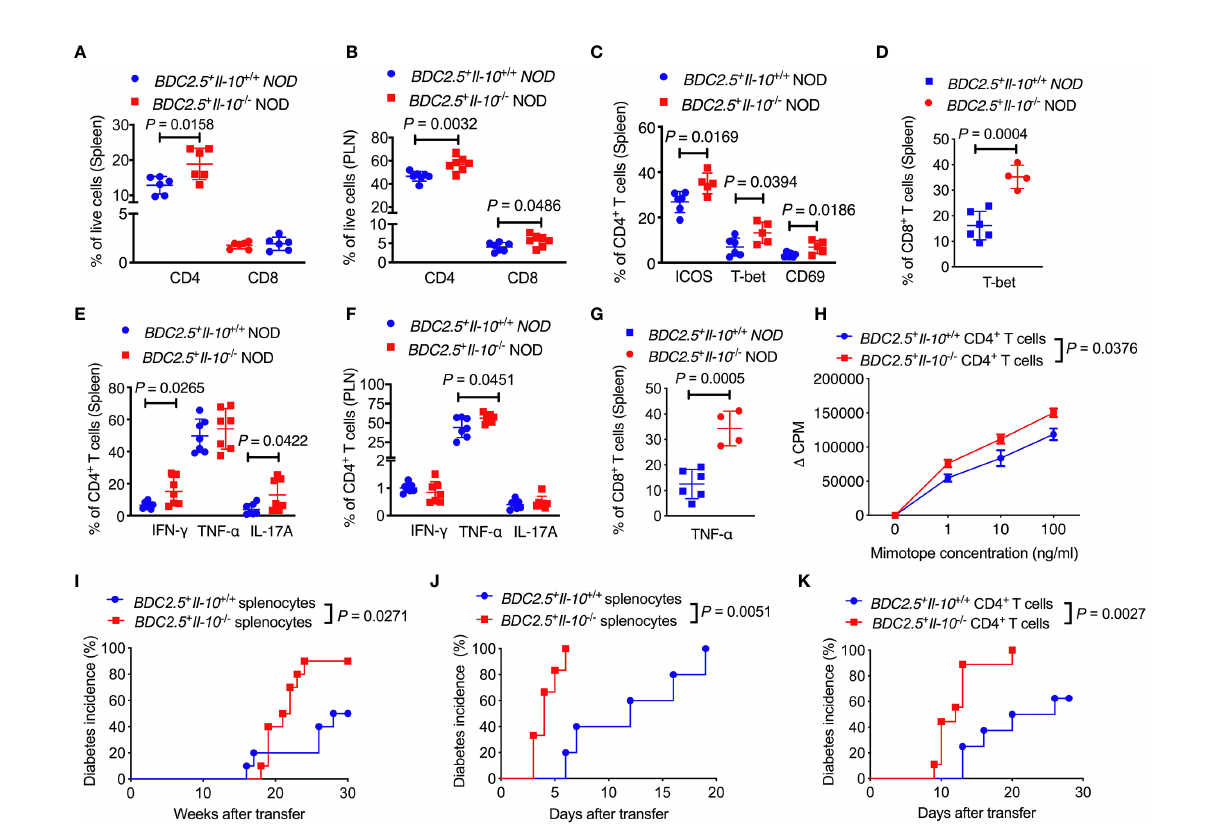
FIGURE 3 | BDC2.5 + Il-10 -/- NOD mice have more activated and pathogenic CD4 + T cells. (A) The percentage of CD4 + T cells and CD8 + T cells in the spleen of BDC2.5 + Il-10 +/+ NOD mice and BDC2.5 + Il-10 -/- NOD mice (n = 6/group). (B) The percentage of CD4 + T cells and CD8 + T cells in the pancreatic lymph node (PLN) of BDC2.5 + Il-10 +/+ NOD mice and BDC2.5 + Il-10 -/- NOD mice (n = 7/group). (C) The proportion of ICOS + , T-bet + and CD69 + splenic CD4 + T cells in BDC2.5 + Il-10 +/+ NOD mice and BDC2.5 + Il-10 -/- NOD mice (n = 5-6/group). (D) The proportion of T-bet + splenic CD8 + T cells in BDC2.5 + Il-10 +/+ NOD mice and BDC2.5 + Il-10 -/- NOD mice (n = 4-6/group). (E) The proportion of IFN- g + , TNF- a + , and IL-17A + splenic CD4 + T cells in BDC2.5 + Il-10 +/+ NOD mice and BDC2.5 + Il-10 -/- NOD mice (n = 7/ group). (F) The proportion of IFN- g + , TNF- a + , and IL-17A + CD4 + T cells in the PLN from BDC2.5 + Il-10 +/+ NOD mice and BDC2.5 + Il-10 -/- NOD mice (n = 7/group). (G) The proportion of TNF- a + splenic CD8 + T cells in BDC2.5 + Il-10 +/+ NOD mice and BDC2.5 + Il-10 -/- NOD mice (n = 4-6/group). (H) Proliferation of puri fi ed splenic CD4 + T cells from BDC2.5 + Il-10 +/+ NOD mice and BDC2.5 + Il-10 -/- NOD mice in the presence of different concentrations of mimotope. (I) Adoptive transfer of diabetic splenocytes from BDC2.5 + Il-10 +/+ NOD mice and BDC2.5 + Il-10 -/- NOD mice into irradiated wild-type NOD mice (n = 10/group). (J) Adoptive transfer of non- diabetic splenocytes from BDC2.5 + Il-10 +/+ NOD mice and BDC2.5 + Il-10 -/- NOD mice into NOD- scid mice (n = 7-9/group). (K) Adoptive transfer of puri fi ed splenic CD4 + into NOD- scid mice (n = 8-9/group). Data in (A – C, E, F, I – K) were combined from two or more independent experiments. The experiments in (D, G, H) were performed two or more times, with similar results obtained. Data in (A – G) are shown as mean ± SD. Data were analyzed using a two-tailed Student ’ s t -test (A – G) , a two-way ANOVA (H) , or log-rank test for survival (I – K) . P < 0.05 was considered statistically signi fi